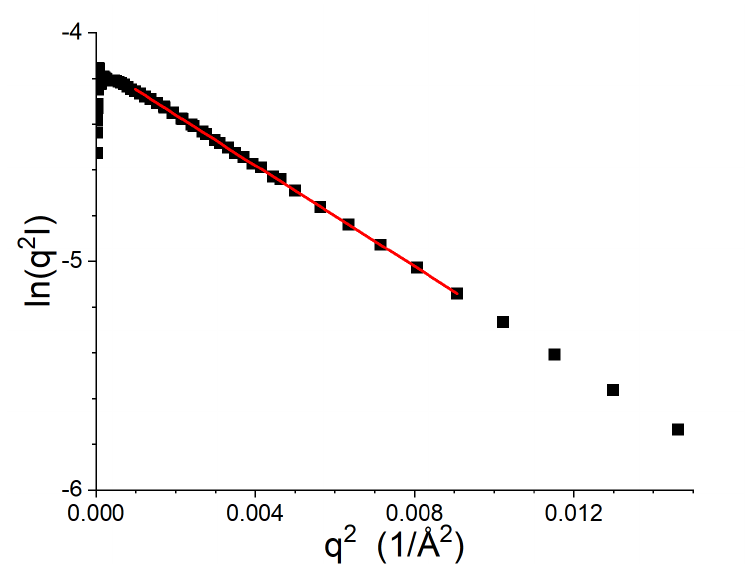
Figure 4. Example of fitting data using Equation (5). The SANS data from Figure 3B are the black squares, while the results of the fit using Equation (5) are shown as the solid red line. T v is 36.4 Å. The low Q portion of the data was not fit because the oscillations resulting from the form factor of the entire vesicle are